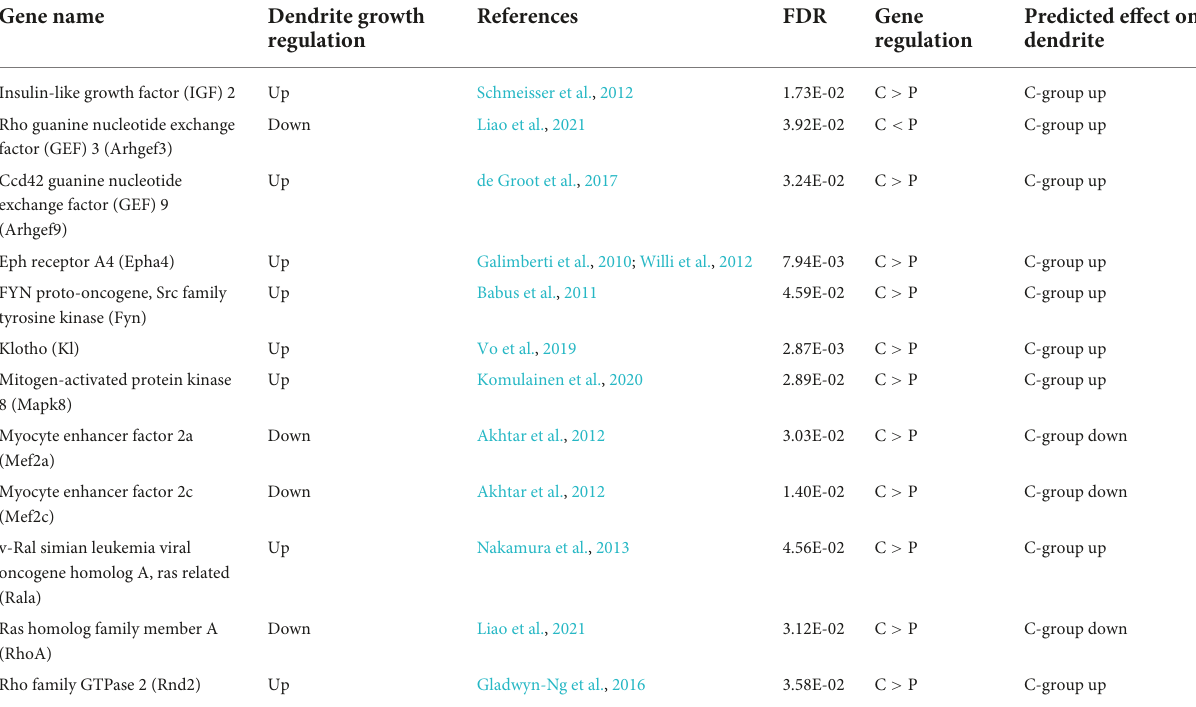
TABLE 2 Genes associated with dendrite